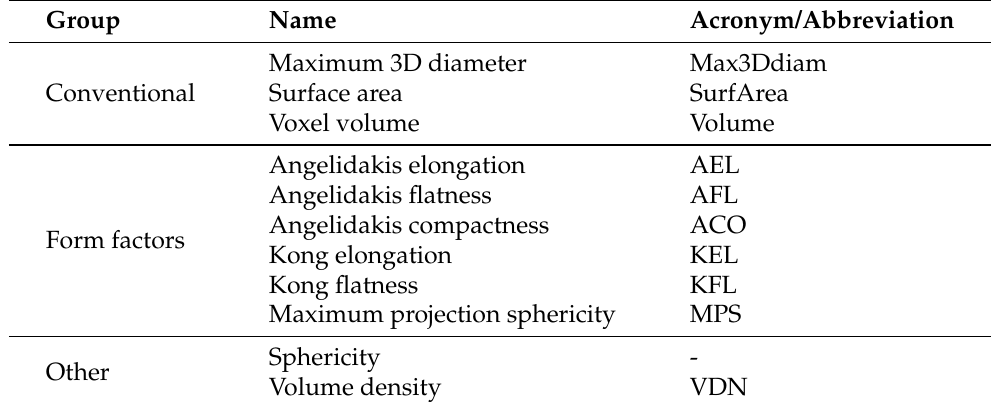
Table 3. Summary table of the shape features considered in this study (see Appendix A for the mathematical definitions and